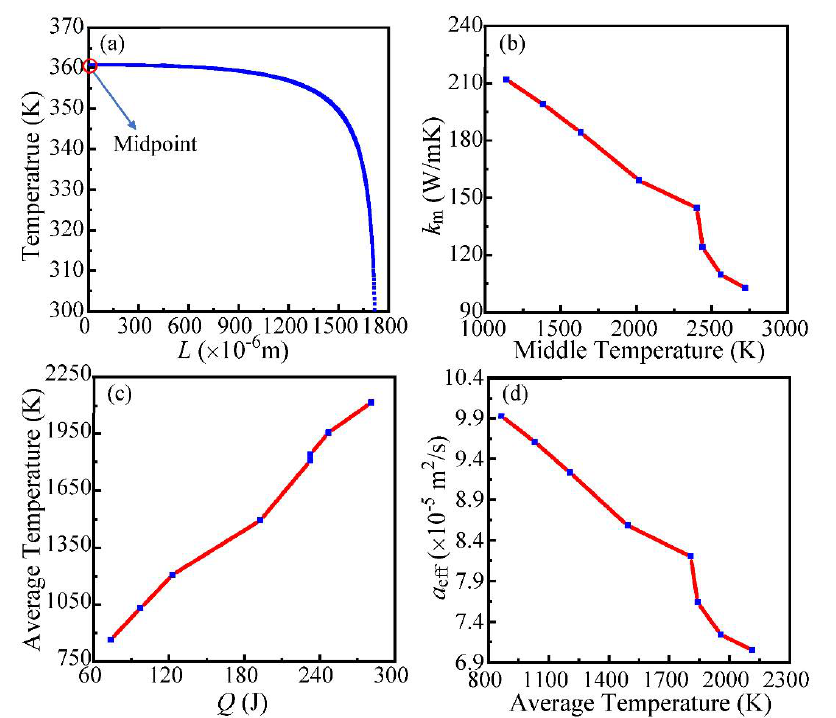
Figure 8. ( a ) Temperature distribution along the length of CNTF. The x-coordinate zero is the midpoint of the sample. ( b ) Thermal conductivity of the midpoint varies with the annealing temperature of the midpoint. ( c ) The average temperature of CNTF under different heating conditions after switch-on. ( d ) The thermal diffusivity varies with the average annealing temperature.